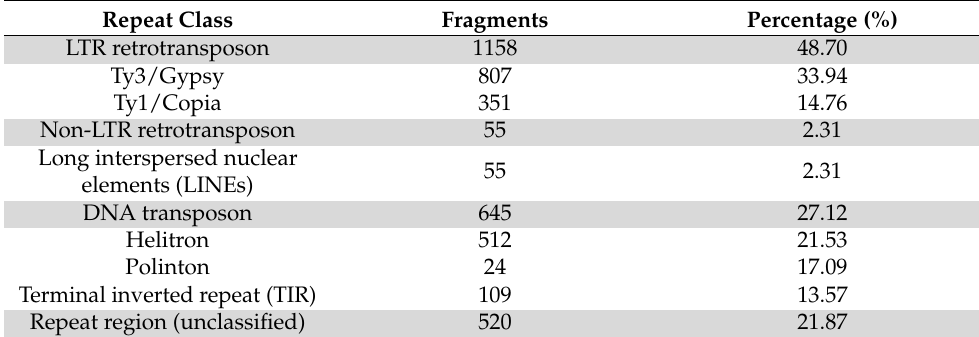
Table 2. Repeat searches for single-nucleotide polymorphisms and restriction fragments of male- linked loci on chromosome 9 in Siamese fighting fish ( Betta splendens Regan, 1910) [1]. Repeat